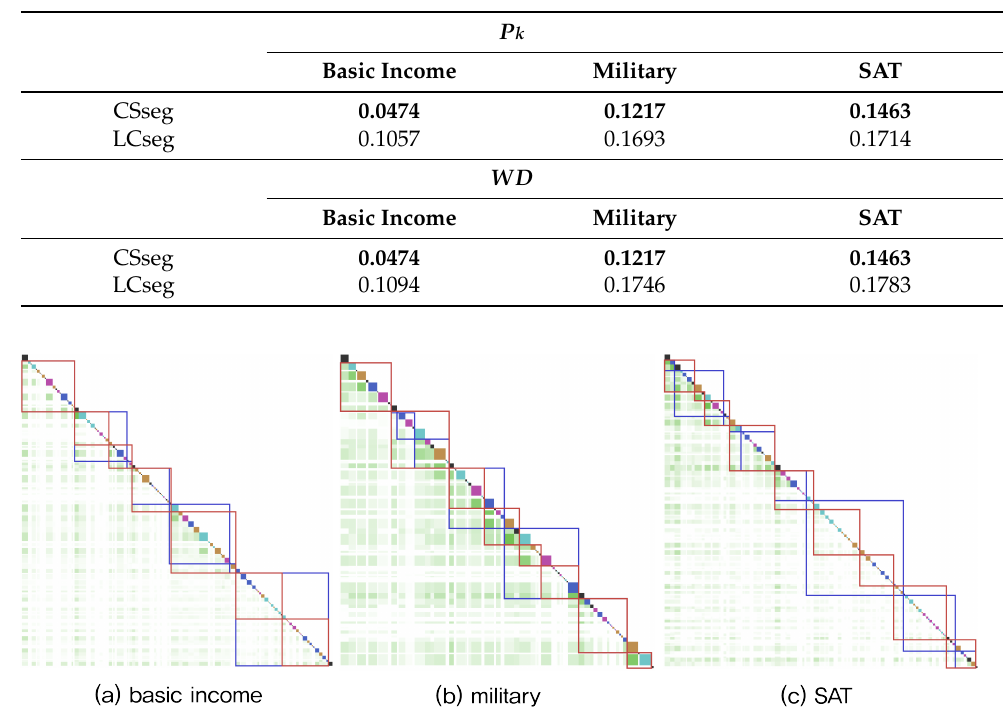
Figure 27. Topic segments of CSseg where Plane, Line, and Point are combined and the debate consistency metrics are applied.